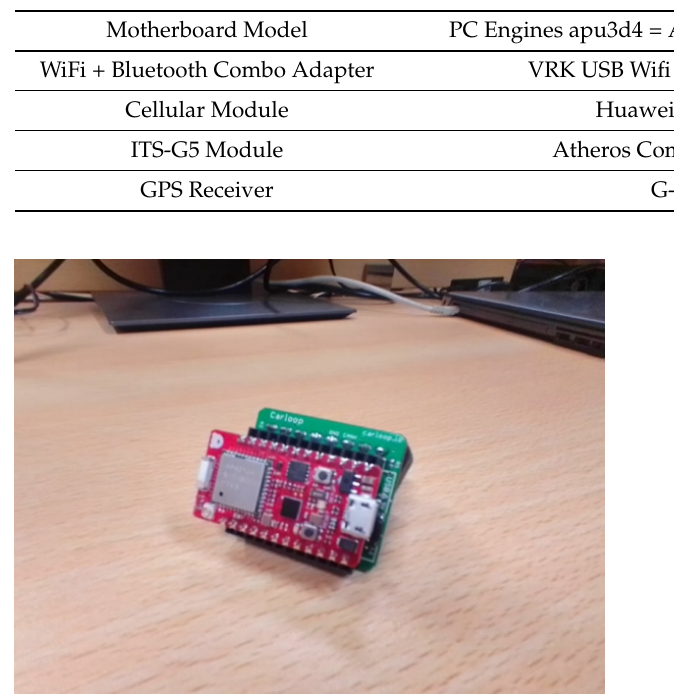
Figure 1. CAN transceiver and controller.